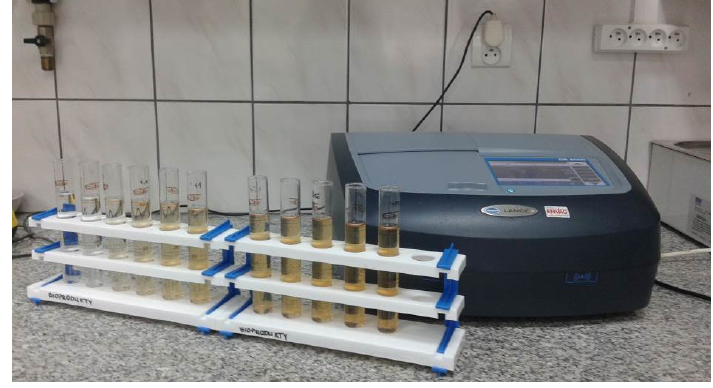
Figure 6. Experimental set-up to determine ammonium in groundwater